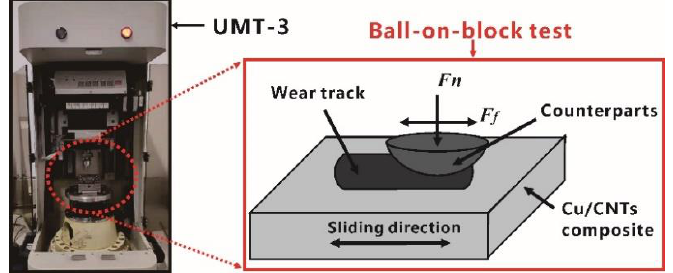
Figure 2. Schematic illustration of ball-on-block tribometer.